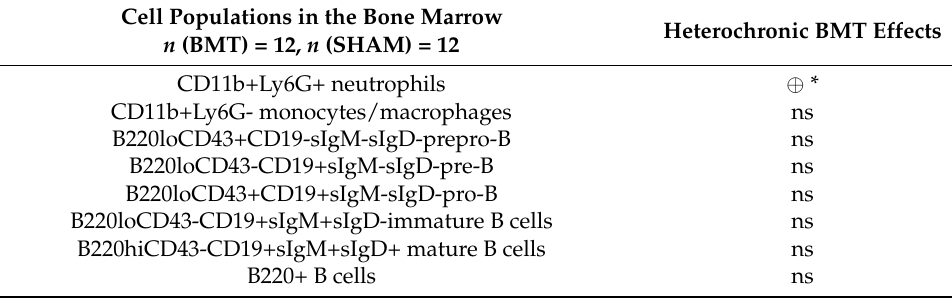
Table 2. Immunophenotyping by flow cytometry (cell source: bone marrow). Cell Populations in the Bone Marrow